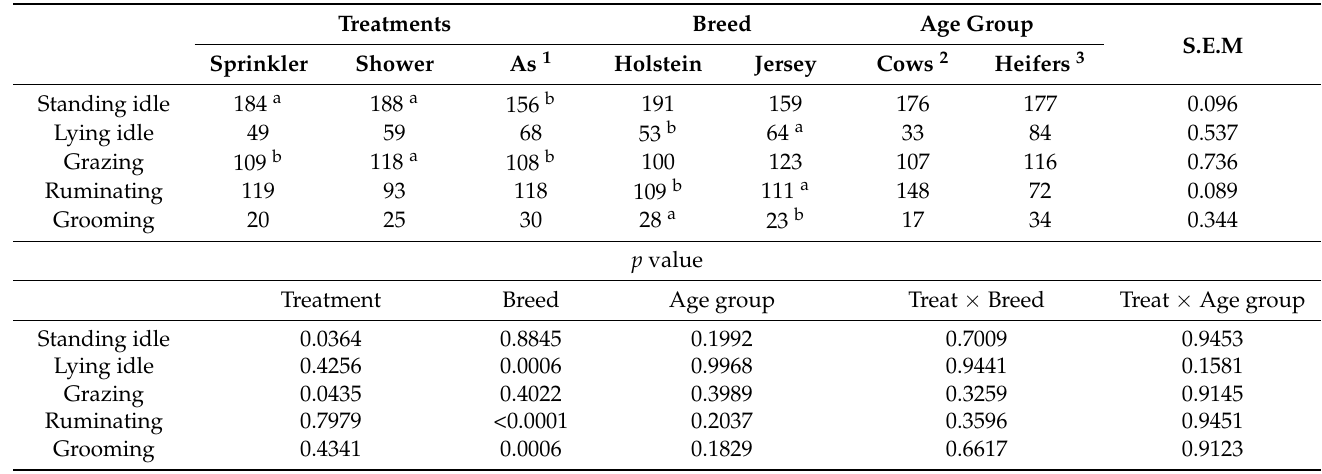
Table 2. Duration (minutes) of behavioral activities in relation to different pasture heat-stress-re- duction systems.